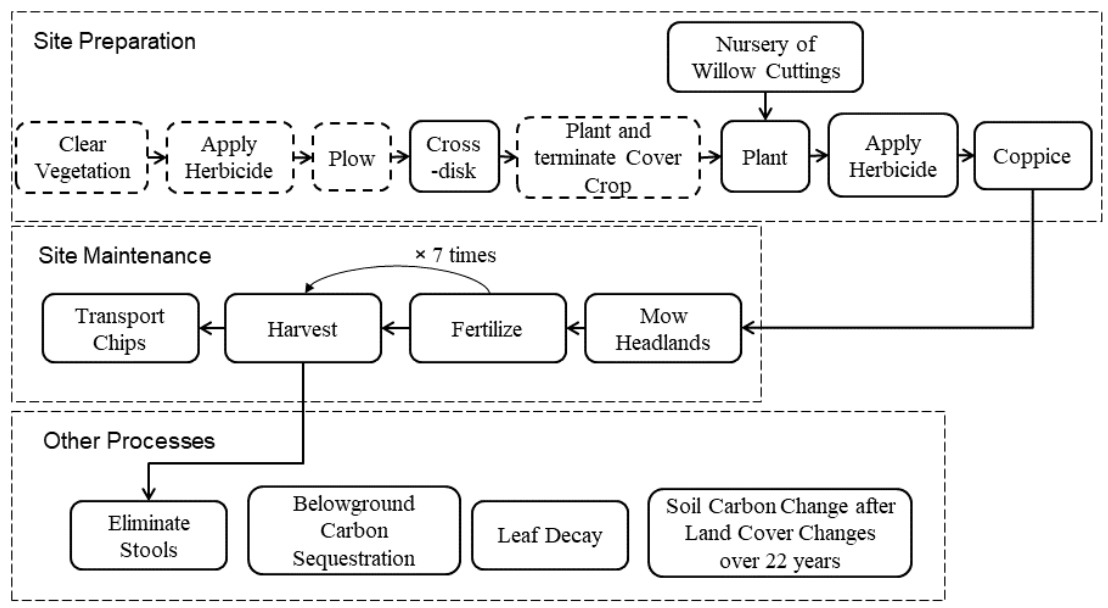
Figure 1. System diagram of willow production supply chain with boundaries and major processes affecting greenhouse gas (GHG) emissions and energy consumption. Site preparation and planting processes occur once in the lifetime of the willow crop.